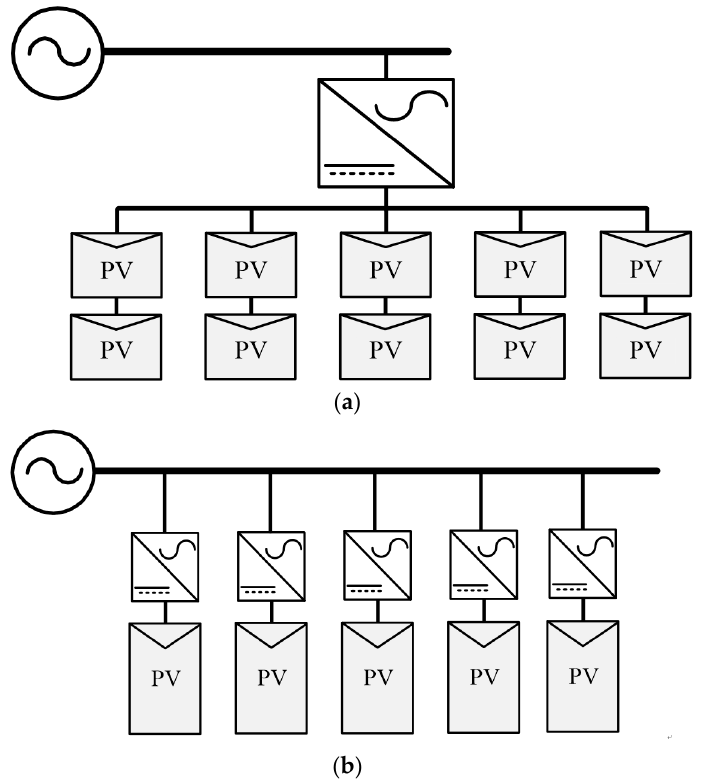
Figure 1. PV system configurations. ( a ) Conventional string type; ( b ) multiple microinverters type.